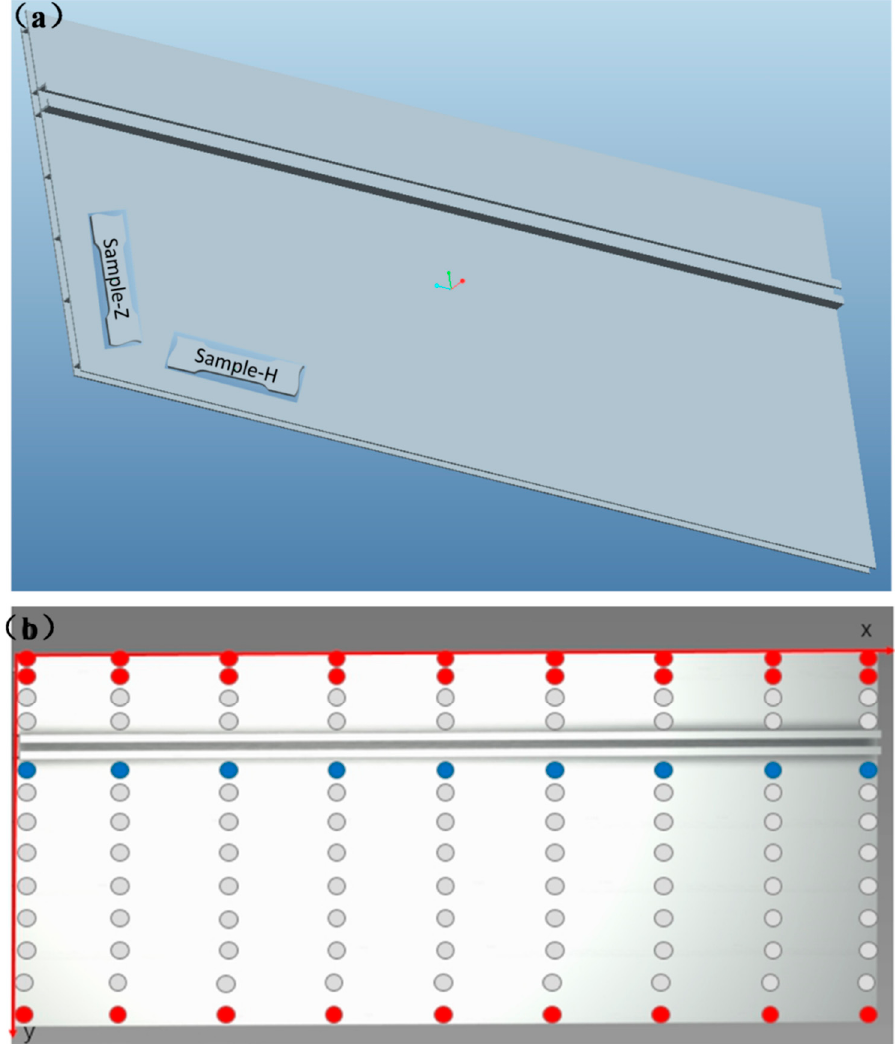
Figure 1. The schematic diagrams of the commercial 6005A-T6 extrusion profile for high-speed trains in different views: ( a ) 3D view and ( b ) top view. The fabricated tensile samples parallel and perpendicular to the extrusion direction are labeled by H and Z, respectively. The red, navy, and gray points highlight the selected region with the maximum, the normal, and the minimum value of the eddy current, respectively.